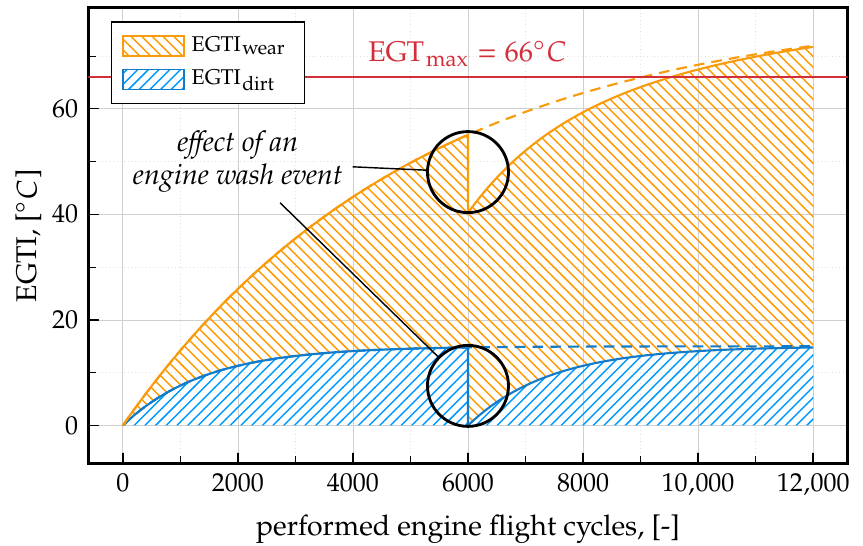
Figure 14. Exhaust Gas Temperature Increase (EGTI) of the CFM56-5B3 including an engine